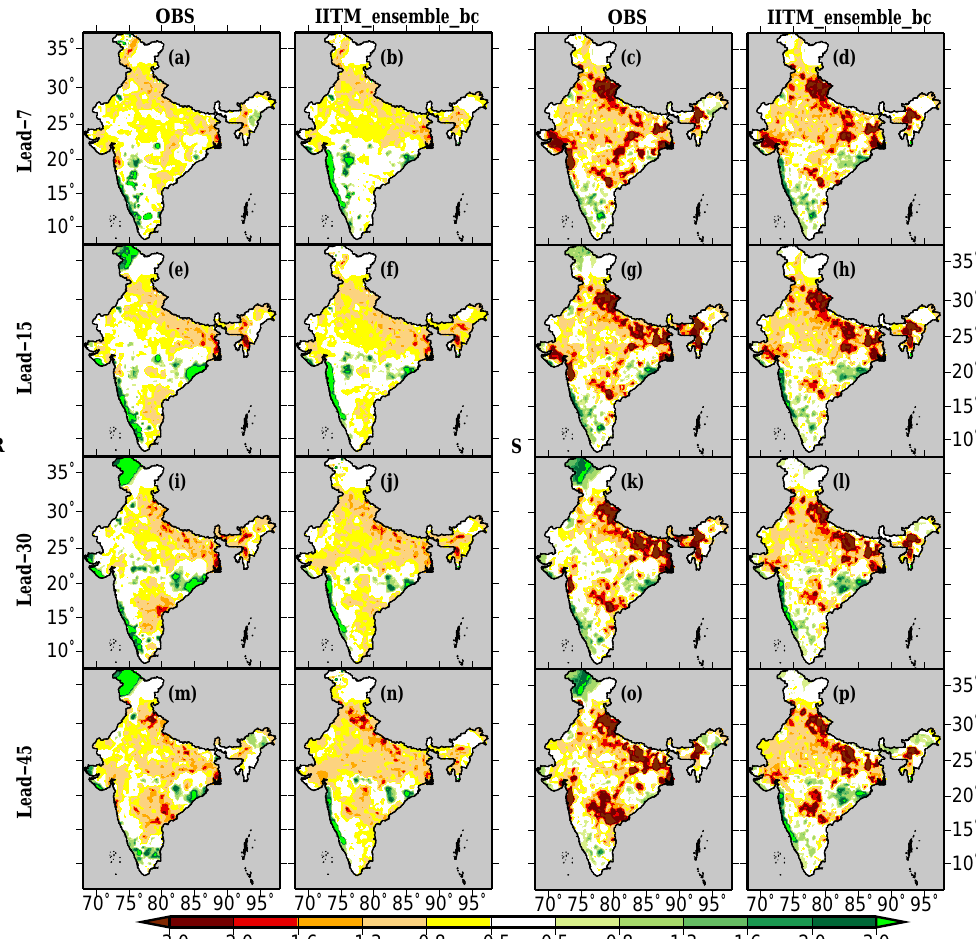
Figure 5. Predicted anomalies of hydrologic variables for the forecast initiated on 15 July 2009 for the accumulation periods of 7, 15, 30, and 45 days. (a) Observed (standardized) anomalies in (VIC-simulated) runoff at a lead time of 7 days. (b) Anomalies in (VIC-simulated) runoff using the bias corrected IITM ensemble for the accumulation period of 7 days. (c, d) Same as (a, b) but for root-zone soil moisture. (e–p) Same as (a) – (d) but for the accumulation periods of 15, 30, and 45 days,